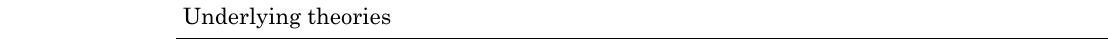
Table 2. Alignment models’ theoretical